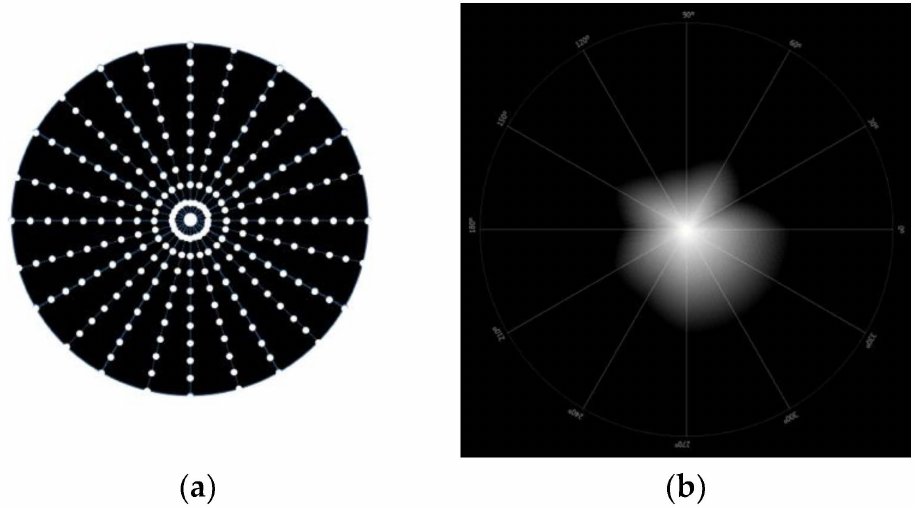
Figure 3. Representative images of LDA device. ( a ) Representative figure of the LDA system; ( b ) simulated image of the light disturbance of one measure, presented by the LDA